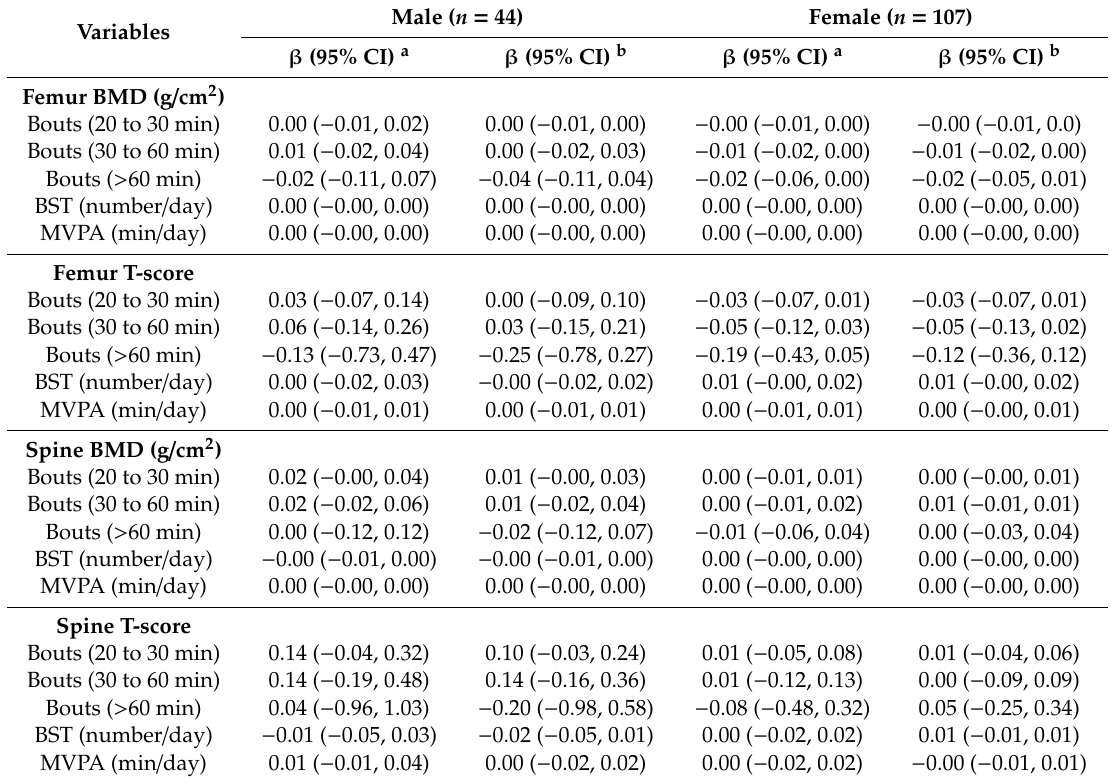
Table 2. Cross-sectional associations of the MVPA and sedentary patterns with BMD (proximal total femur and lumbar spine) controlling for